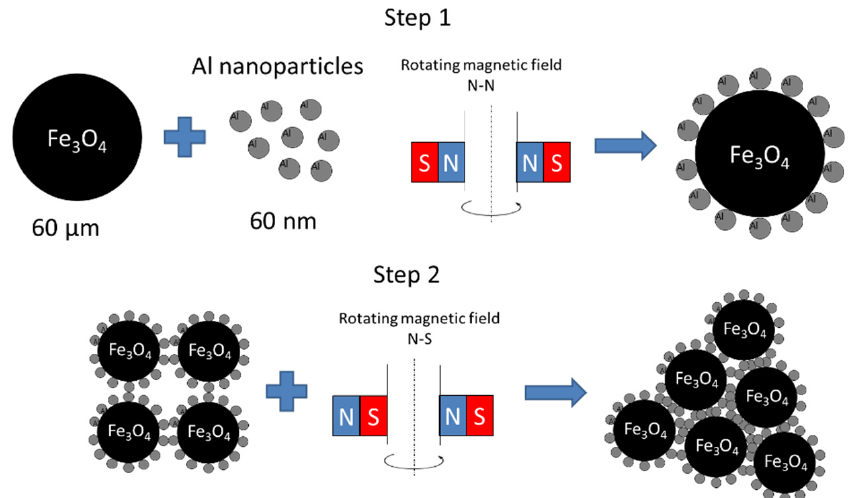
Figure 1. Scheme of Fe 3 O 4 particles coating by Al nanoparticles using N–N rotating magnetic field (step 1) and composite material synthesis using N-S rotating magnetic field (step 2).